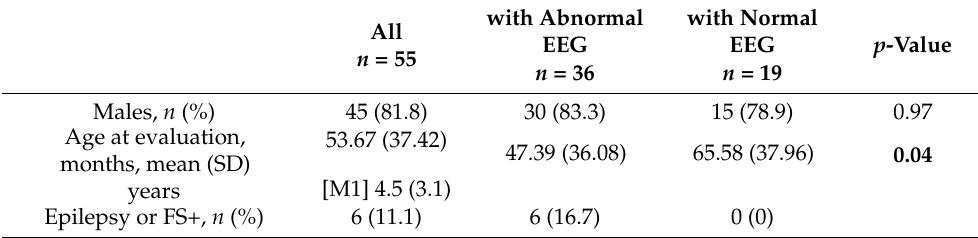
Table 1. Demographics and clinical characteristics.